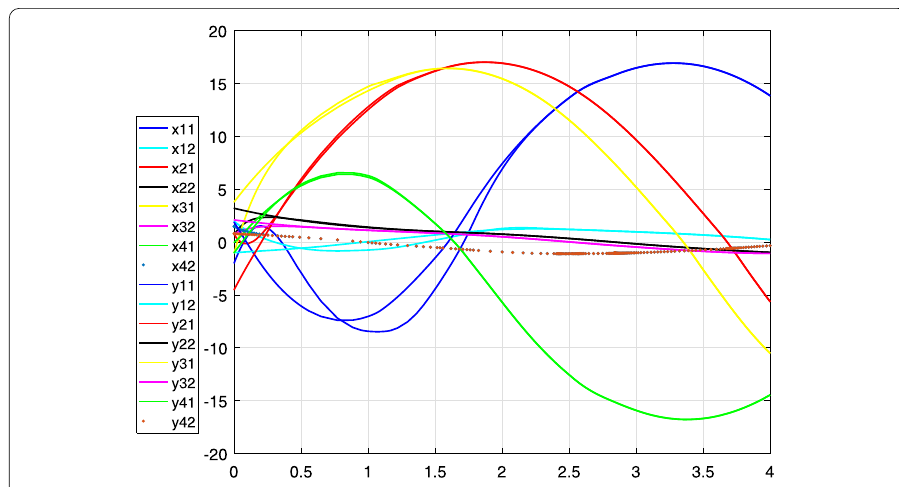
Figure 1 Time evolution of x 1 ( t ), x 2 ( t ), x 3 ( t ), x 4 ( t ), y 1 ( t ), y 2 ( t ), y 3 ( t ), y 4 ( t ) with controllers